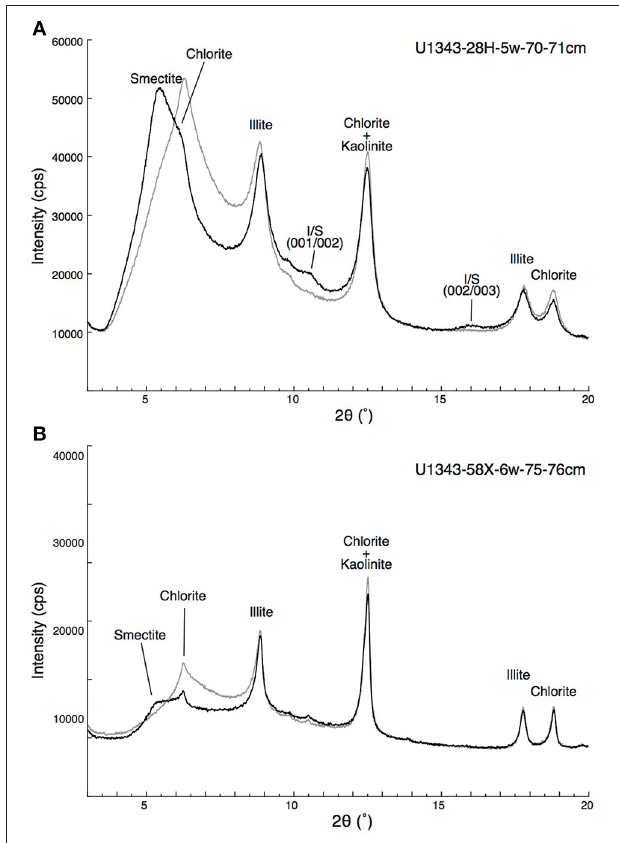
FIGURE 5 | Representative X-ray diffractograms of the clay-size fraction at Site U1343. (A) Clay-rich sediment from U1343-28H-5w-70-71cm and (B) clay-poor sediment from U1343-58X-6w-75-76cm. Gray and black lines show results from air-dried and EG saturated samples, respectively.